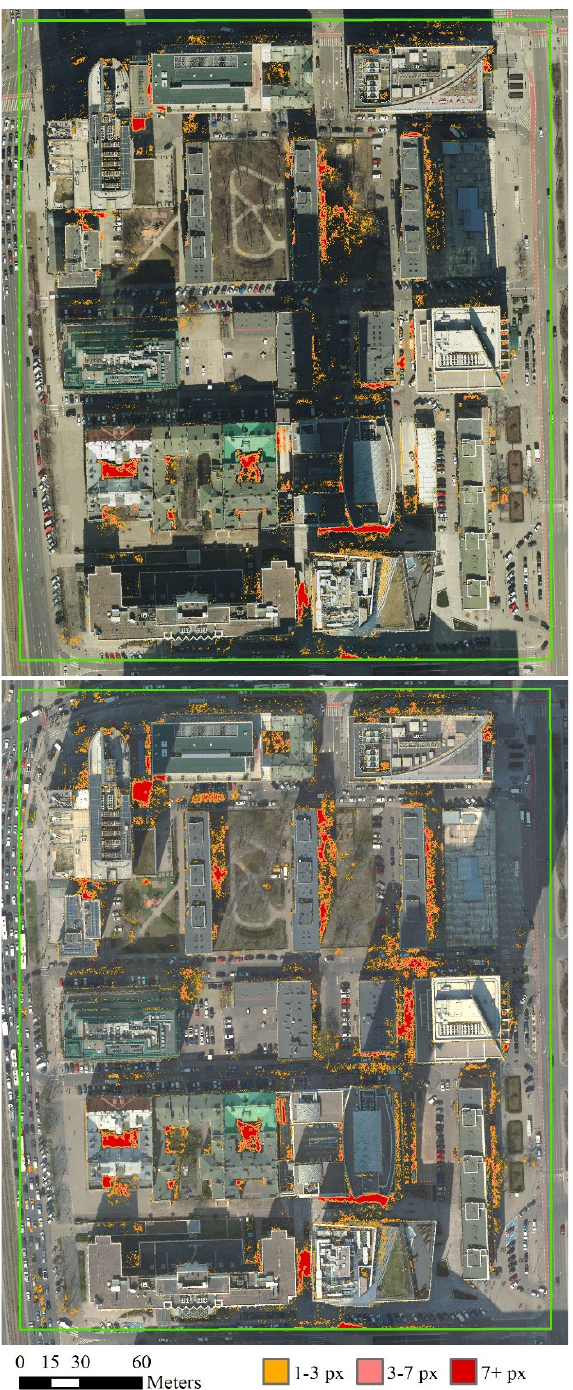
Figure 7. True orthophotos with classified interpolation distance for the 4 th test area (marked with the green outline) from top: 2018 (80/60) dataset, 2019 (80/60)